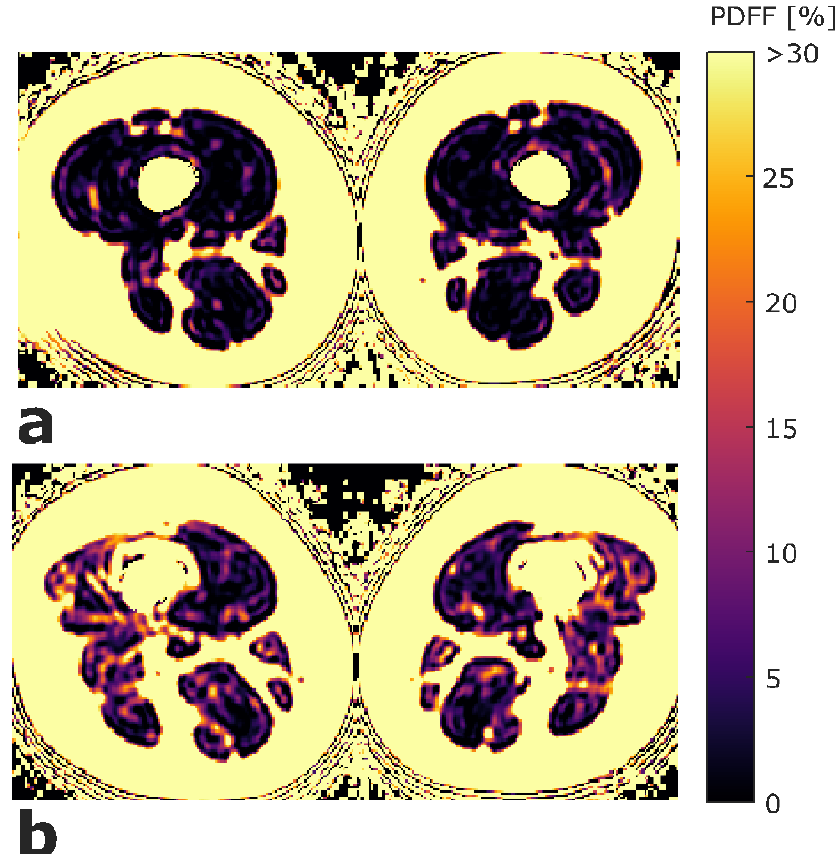
Figure 2. Exemplary color-coded axial PDFF maps of two study participants. ( a ) Participant with high strength (left side: MVIC EXT = 281.7 Nm, MVIC FLEX = 113.5 Nm; right side: MVIC EXT = 298.7 Nm, MVIC FLEX = 147.0 Nm) and low mean PDFF values (left side: PDFF EXT = 1.07%, PDFF FLEX = 1.46%; right side: PDFF EXT = 0.31%, PDFF FLEX = 0.98%). ( b ) participant with low strength (left side: MVIC EXT = 126.7 Nm, MVIC FLEX = 77.2 Nm; right side: MVIC EXT = 149.1 Nm, MVIC FLEX = 68.1 Nm) and high mean PDFF values (left side: PDFF EXT = 5.31%, PDFF FLEX = 6.94%; right side: PDFF EXT = 4.71%, PDFF FLEX = 8.59%). The upper limit of the color window was set to 30% to better depict the PDFF values within the thigh muscles. (PDFF EXT/FLEX , proton density fat fraction of quadriceps and ischiocrural muscles; MVIC EXT/FLEX , maximum voluntary isometric contraction of extension and flexion; Nm, newton meter)